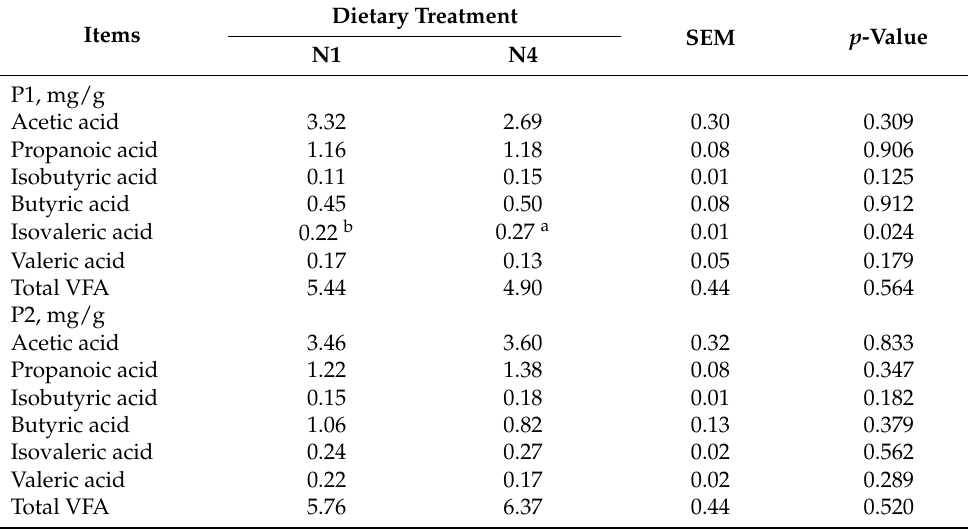
Figure 5. Species between-group difference test (genus level). ( a ), t -test between N1.P1 group and N4.P1 group; ( b ), t -test between N1.P2 group and N2.P2 group. P1: the experimental period is 7 days. P2: the experimental period is 14 days. N1: 22.5 mg/kg niacin group. N2: 30 mg/kg niacin group. N3: 45 mg/kg niacin group. N4: 75 mg/kg niacin group. Table 7. The concentration of colon contents in weaned piglets with different niacin concentrations 1